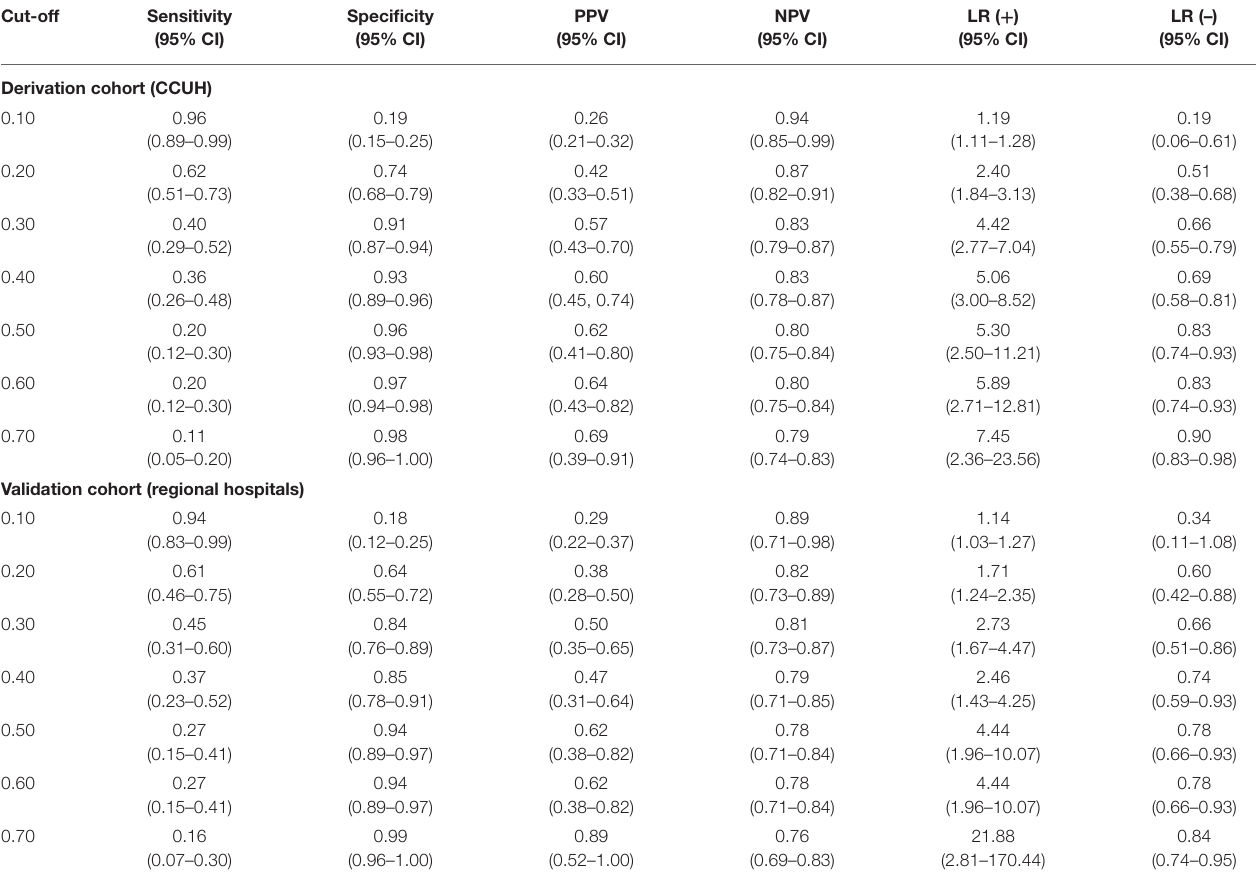
TABLE 6 | Diagnostic performance of CPM 1 at different cut-off points in derivation and validation cohorts.